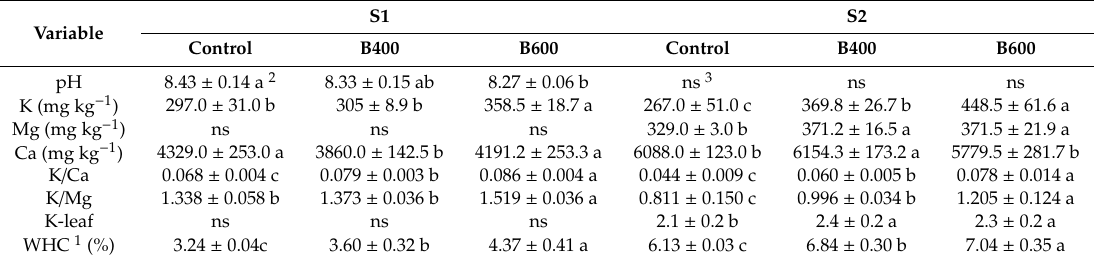
Table 7. Nutrient concentrations in growing media and sorghum leaves, and water holding capacity (WHC) with di ff erent pyrolysis temperatures of biochar (400 ◦ C—B400 and 600 ◦ C—B600; S1: sandy-loam growing substrate; S2: clay-loam growing